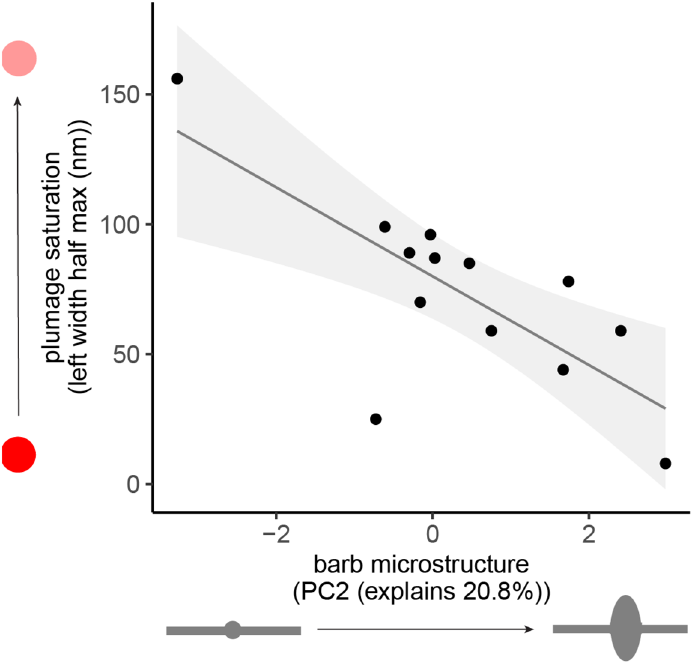
Figure 5. Male barb microstructure correlates significantly with plumage saturation. Wider, more oblong male barbs are correlated with more saturated plumage, as measured through left-width half-maximum of reflectance curve (see Fig. 2). We performed a PGLS with microstructure PC2 and PC1 scores as independent variables, and with plumage saturation as dependent variable (PC2 coefficient = 20.8, SE 6.79, p < 0.025; PC1 coefficient = 12.6, SE = 7.49; p =